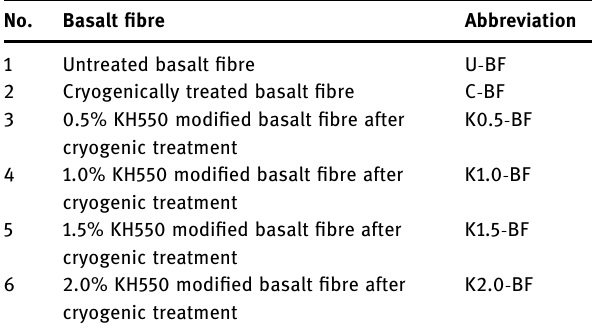
Table 2: Abbreviations for di ff erent treatments of BFs